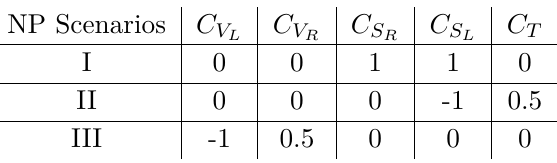
Figure 3. Illustration of the possible bounds on (left) C V assuming a 10% SM measurement.